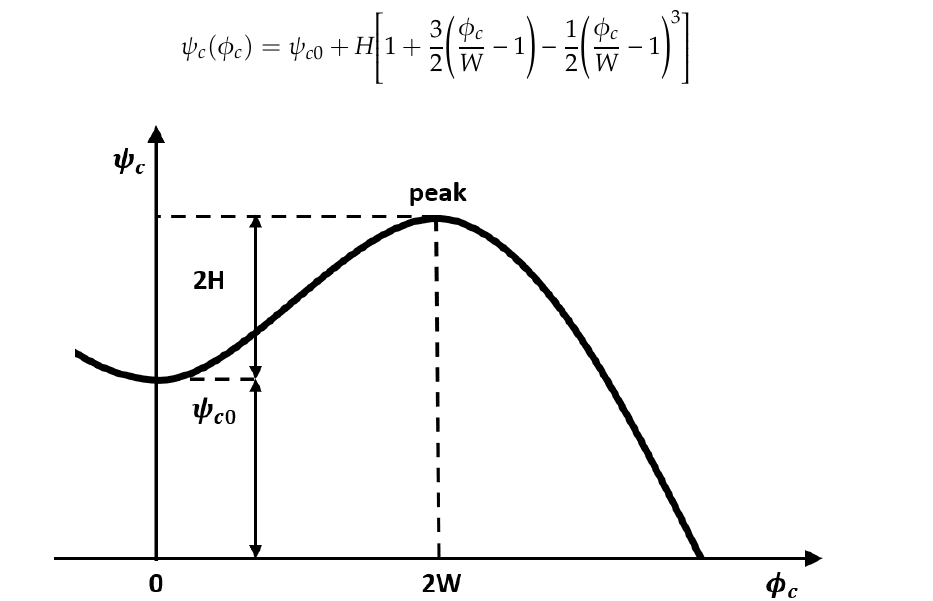
Figure 2. Third order polynomial compressor performance curve approximation [29].